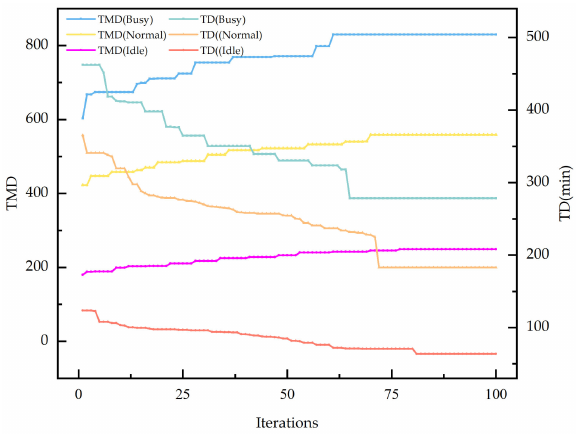
Figure 4. The iteration curves of the two optimization